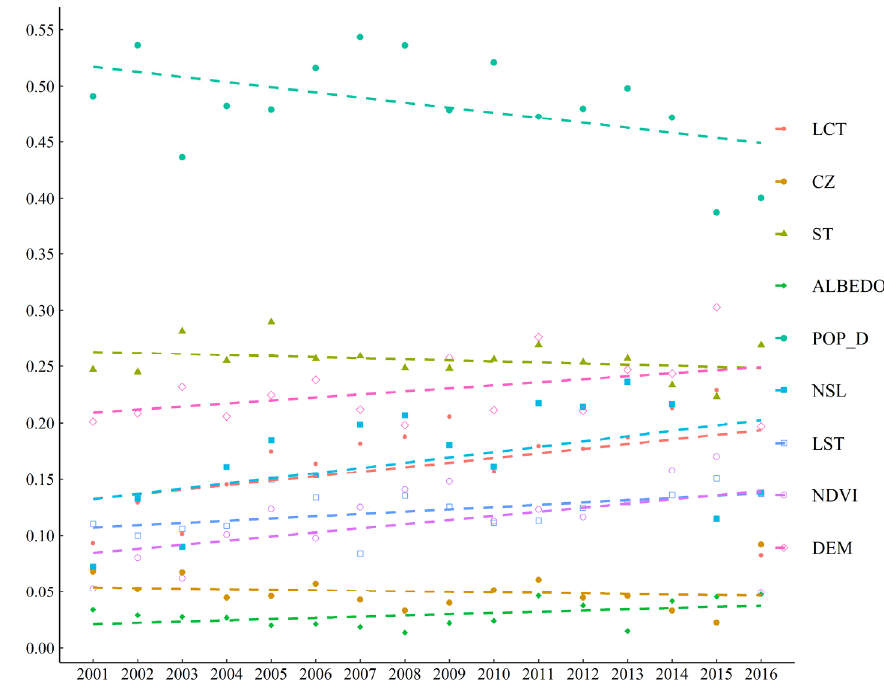
Figure 12. Trend analysis of q value of each driving factors during 2001–2016 for Xinjiang.